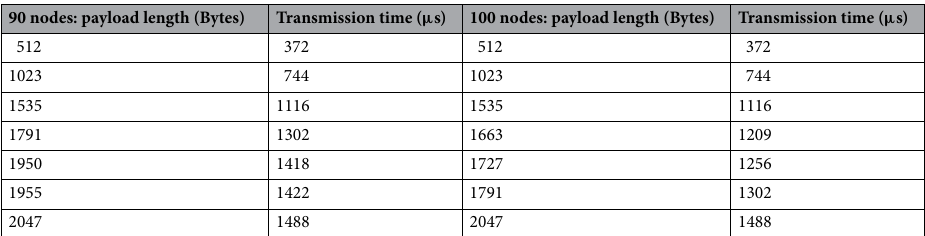
Table 3. Payload Length of 90 nodes and 100 nodes with 11